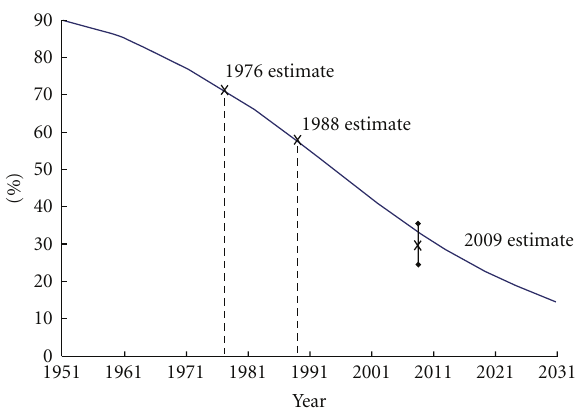
Figure 1: Decline in edentulism prevalence among New Zealand 65–74-year-olds, showing actual estimates from the 1976, 1988, and 2009 national oral health surveys, along with logistic line fitted in 1997 using the 1976 and 1988 estimates (2009 data point depicts 95% confidence